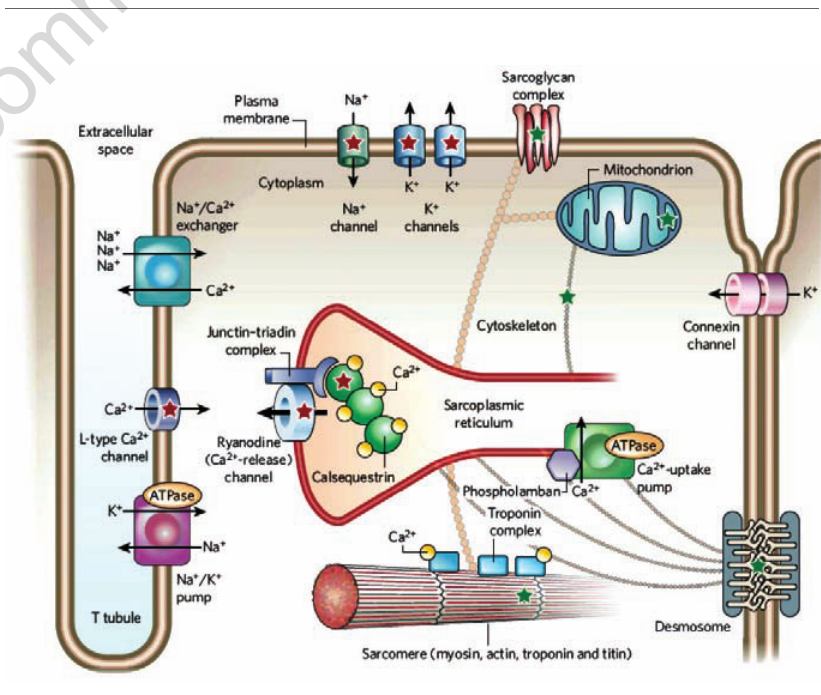
Figure 2. Calcium homeostasis in a ventricular cardiomyocyte. Adapted from Knollmann et al., 14 with